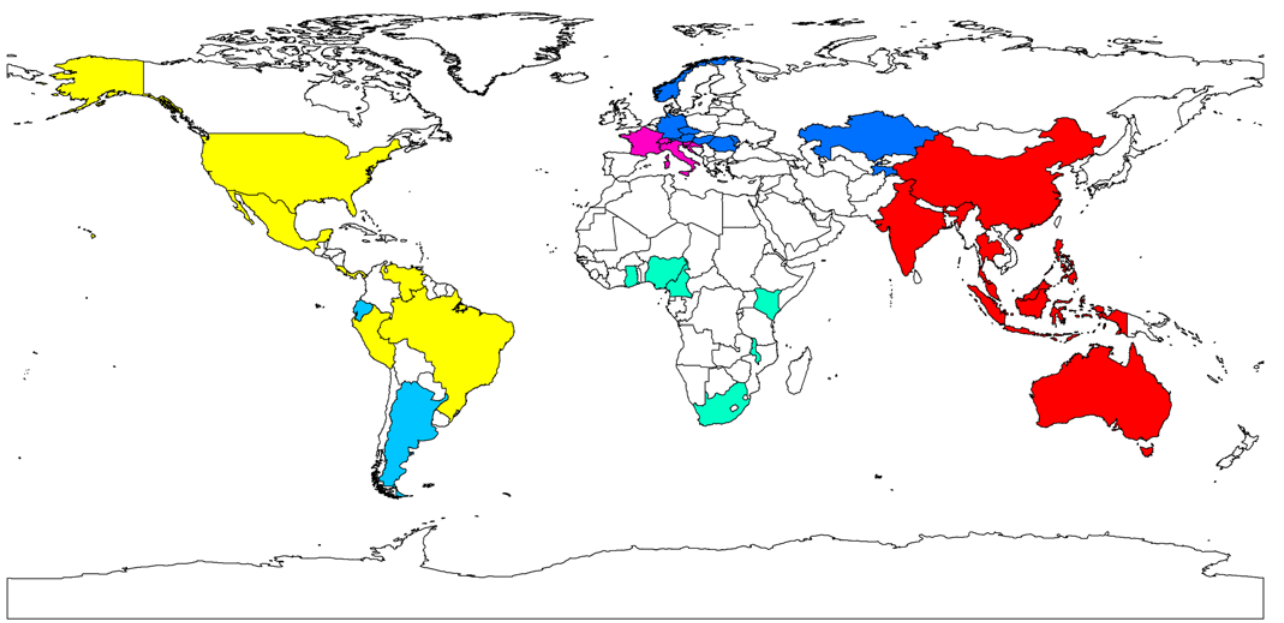
Figure 1. Countries clustering based on fruit fly species assemblages. Map of world showing those countries that were allocated to the same neuron in a SOM analysis (same colour) and hence those countries that have the most similar fruit fly species